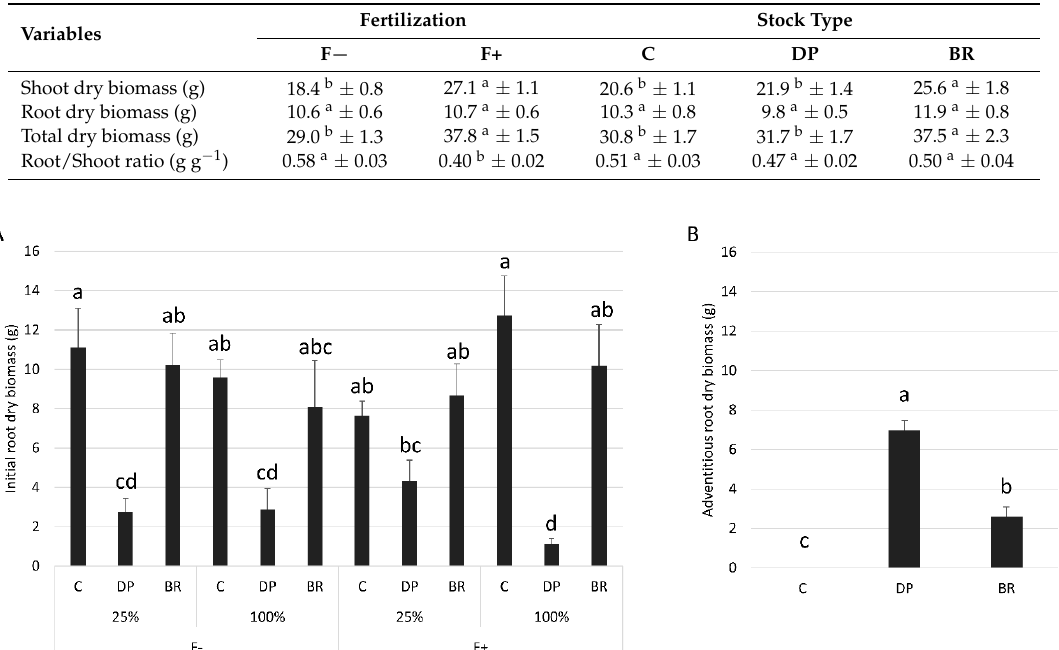
Table 2. Mean ( ± SE) of shoot, root, and total dry biomass and root/shoot ratios according to fertilization (F − without and F+ with fertilization) and stock type (C, containerized seedlings; DP, deeply-planted containerized seedlings; and BR, bareroot seedlings (refer to Figure 1 for description)). Different letters for the same fixed effect (fertilization or stock type) indicate significant differences at P ≤ 0.05.